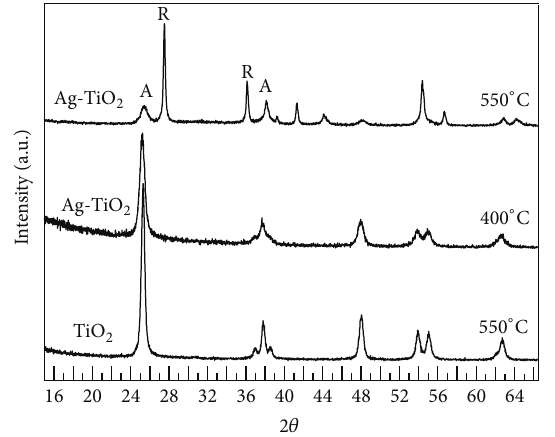
Figure 1: XRD patterns of titania and Ag-doped titania; A: anatase, R: rutile.